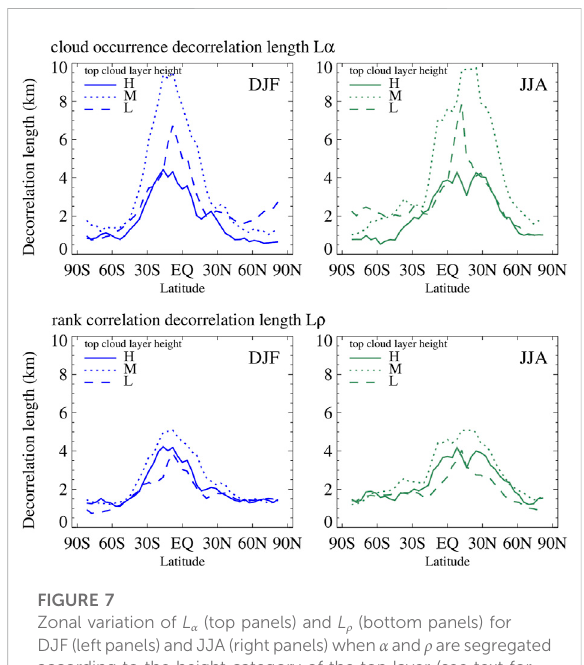
FIGURE 7 Zonal variation of L α (top panels) and L ρ (bottom panels) for DJF(leftpanels)andJJA(rightpanels)when α and ρ aresegregated according to the height category of the top layer (see text for